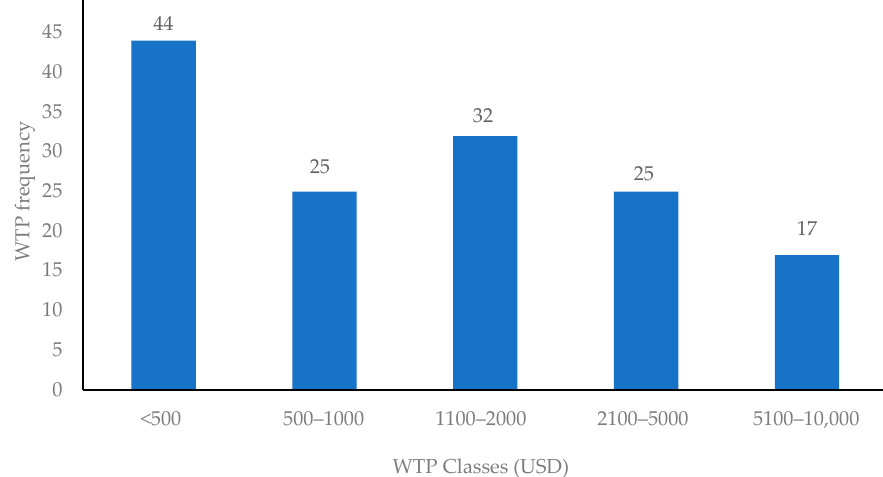
Figure 6. Frequency bar plot of different classes of WTP.